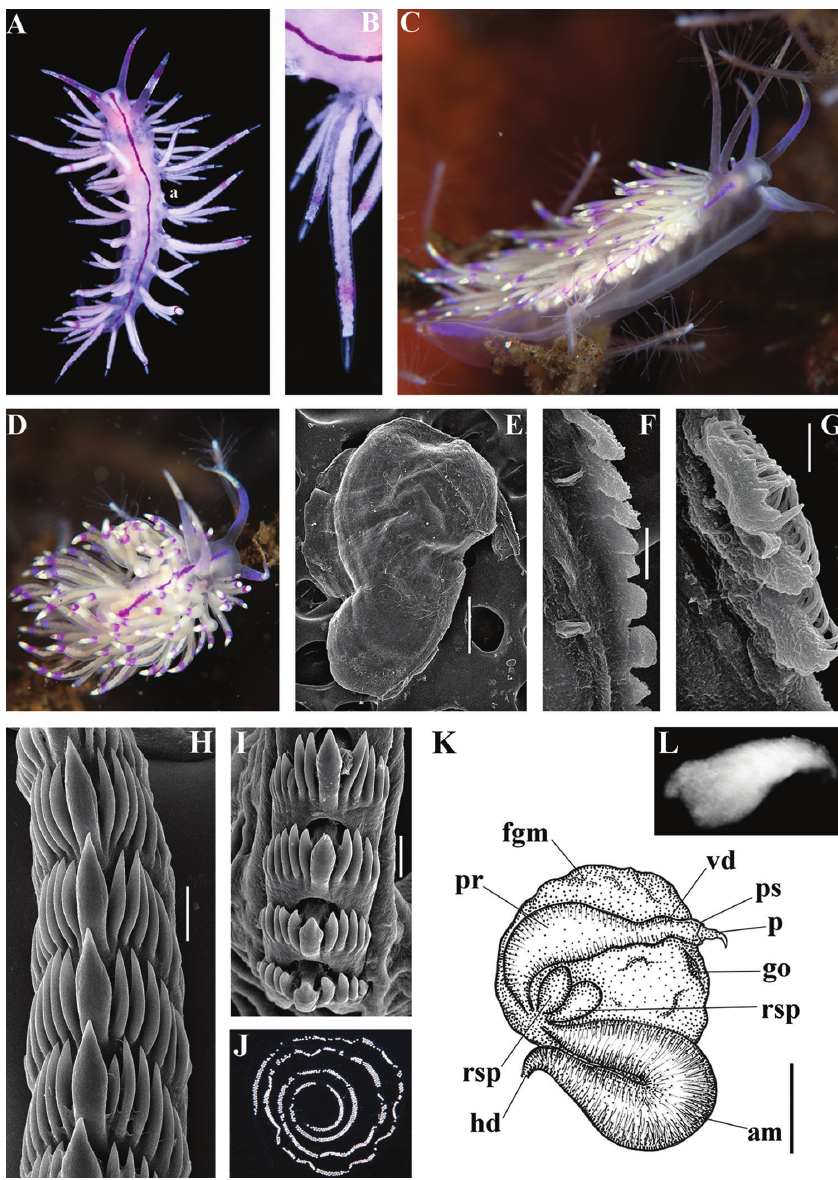
Figure 43. Unidentia sandramillenae sp. n. A holotype ZMMU Op-617, live, dorsal view , 7 mm in length (fixed) B same, details of cerata C uncollected specimen, lateral view D same, among athecate hydroids, pos- sible prey E holotype, jaws, lateral view, SEM F G details of masticatory processes of jaw H posterior rows of radula, SEM I anterior rows of radula J egg mass K scheme of reproductive system L penis with hollow stylet, light microscopy. Abbreviations: am ampulla fgm female gland mass go genital opening hd herma- phoroditic duct p penis pr prostate ps penial sheath vd vas deferens rsp proximal receptaculum seminis Scale bars: E = 200 μm; F =10 μm; G = 5 μm; H, I = 20 μm; K = 0.5 mm. Photos of living specimens and eggs by B. Picton, other photos and SEM images by A.V. Martynov, drawings by T.A.